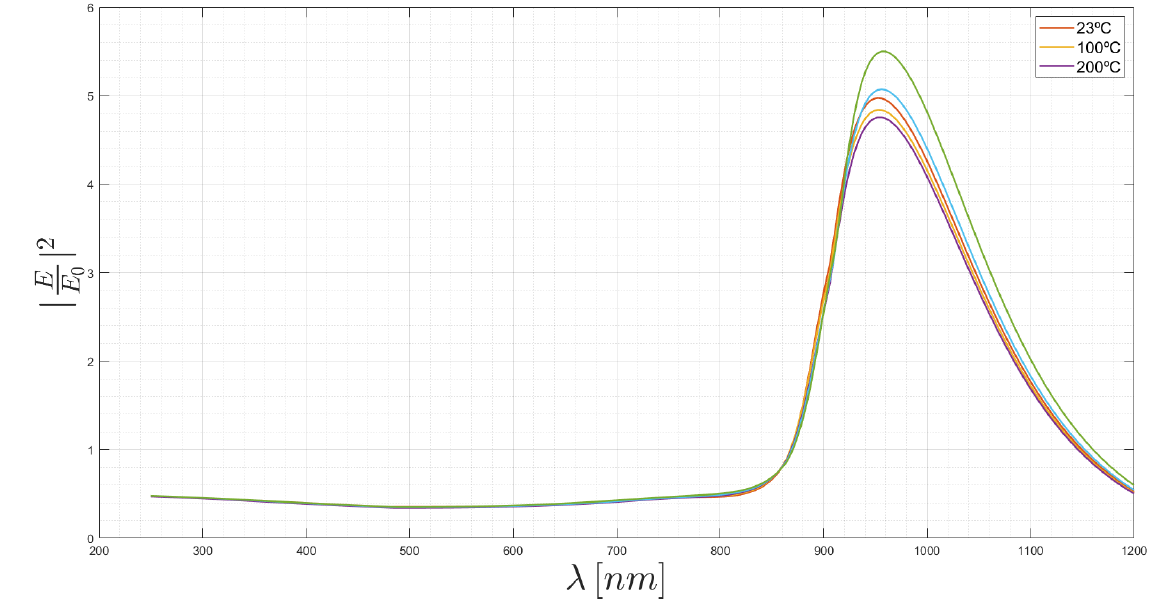
Figure 15. Gold nanostructure response for different